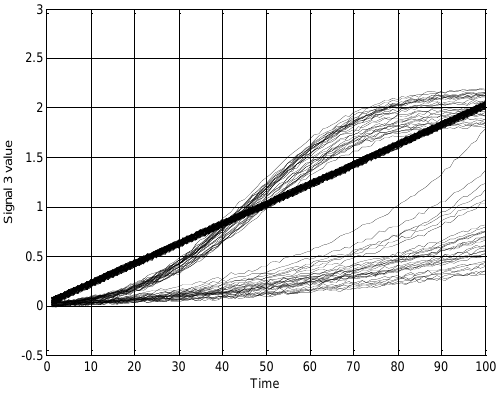
Fig. 3. Projection on the signal 3 axis of the 150 simulated transients.